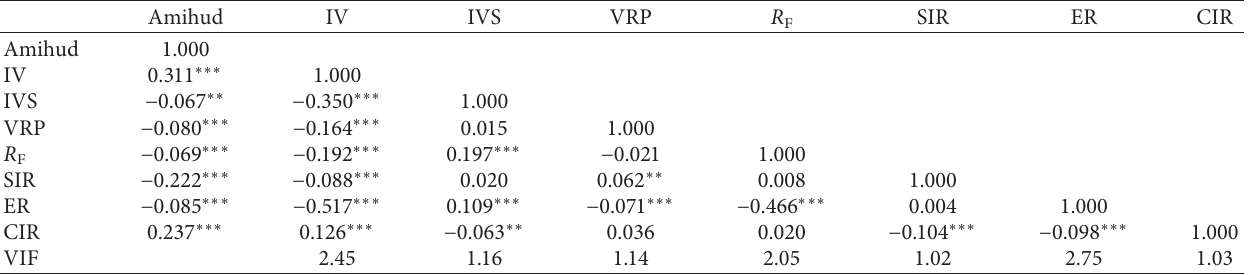
Table 2: Correlation analysis of variables.